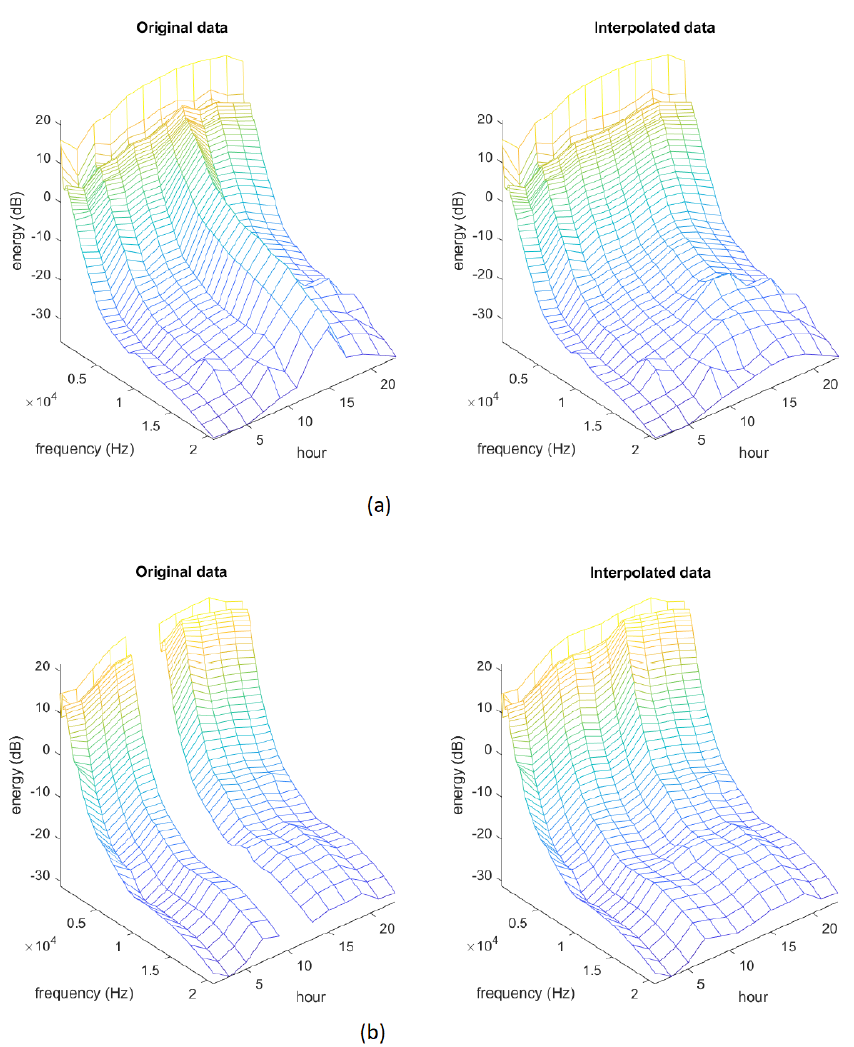
Figure 4. Examples of original (left-side) and interpolated (right-side) STPs for the suburban environ- ment from ( a ) sensor hb140 and ( b ) sensor hb143, respectively.